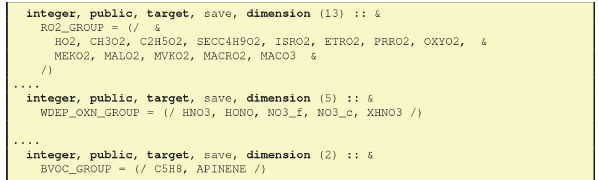
Figure 11. Selected lines from the GenChem-produced file CM_ChemGroups_mod.f90